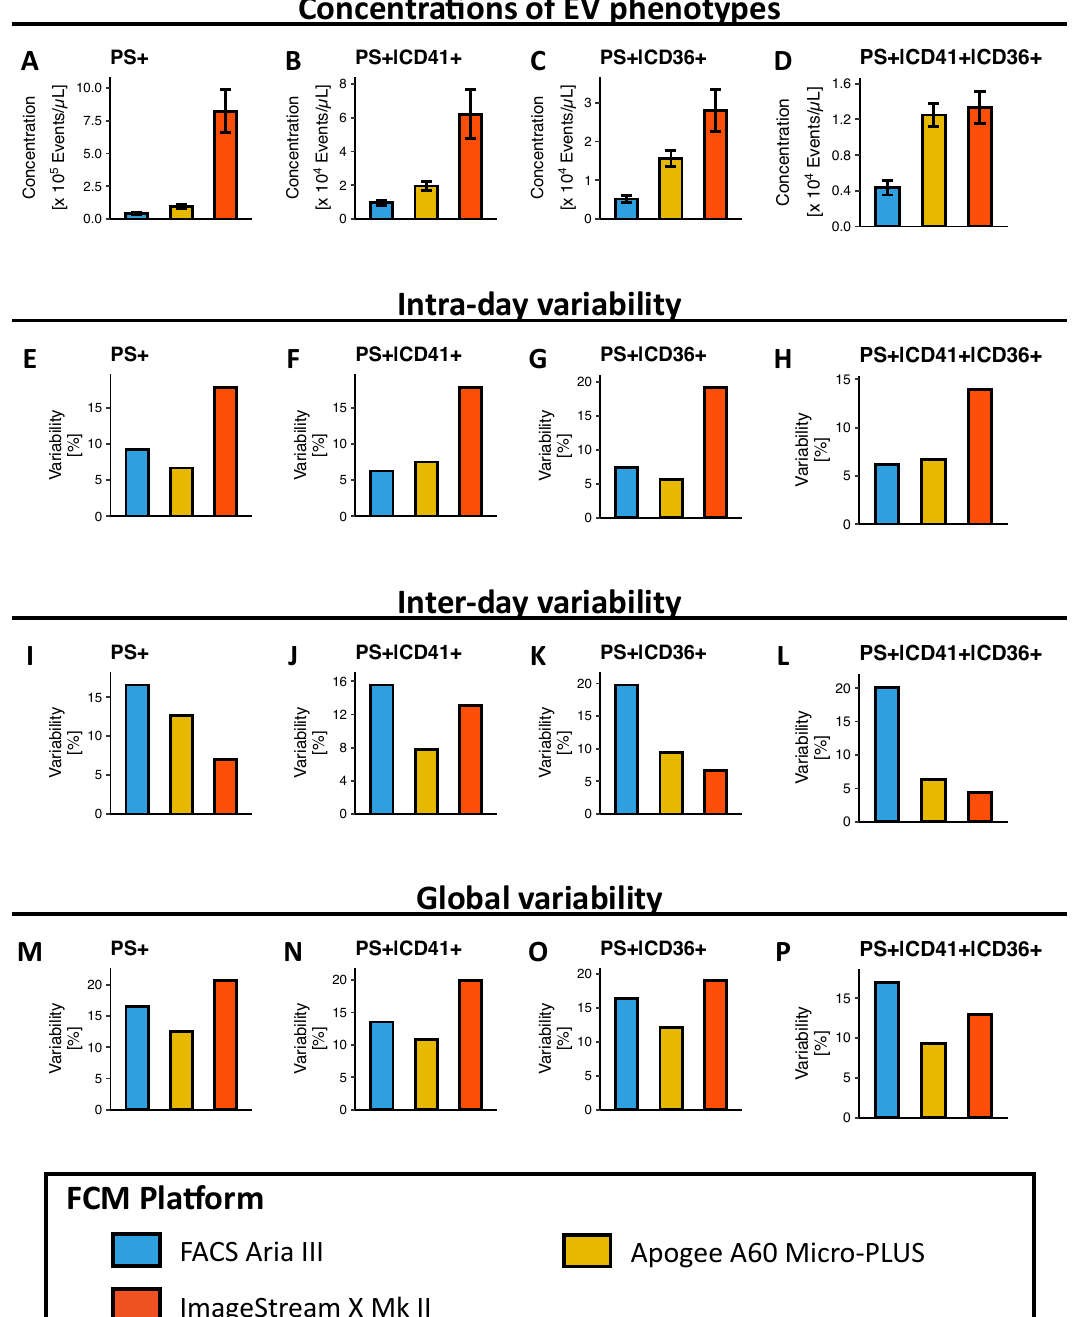
Figure 4. Concentrations and variability in the detection of EV phenotypes on three different flow cytometry platforms. ( A – D ) Concentrations of ( A ) PS+, ( B ) PS+|CD41+, ( C ) PS+|CD36+ and ( D ) PS+|CD41+|CD36+ EVs detected on the three different platforms. Results are depicted as mean (bar) ± 1SD (error bars) of concentrations from the inter-day variability study. ( E – H ) Intra-day variability in the detection of ( E ) PS+, ( F ) PS+|CD41+, ( G ) PS+|CD36+ and ( H ) PS+|CD41+|CD36+ EVs ( n = 20 per platform). ( I – L ) Inter-day variability in the detection of ( I ) PS+, ( J ) PS+|CD41+, ( K ) PS+|CD36+ and ( L ) PS+|CD41+|CD36+ EVs ( n = 5 × 5 per platform). ( M – P ) Global variability in the detection of ( M ) PS+, ( N ) PS+|CD41+, ( O ) PS+|CD36+ and ( P ) PS+|CD41+|CD36+ EVs ( n = 40 per platform). Coefficients of variability (CV) were calculated as SD/mean expressed in